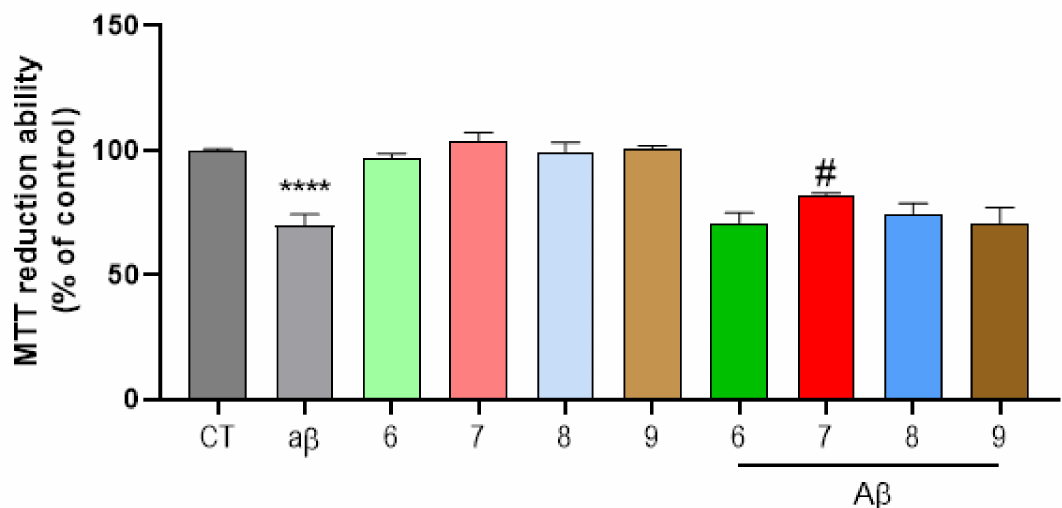
Figure 3. Neuroprotective effect of substances on A β 42 -induced toxicity on SH-SY5Y cells. SH-SY5Y cells were treated with A β 42 peptide (2.5 µ M) for 24 h in the absence or in the presence of the compounds. When compounds were present, a pre- incubation of 1 h preceded the A β 42 treatment. Cellular viability was measured by using the MTT reduction assay. Results are expressed relatively to SH-SY5Y untreated cells, with the mean ± SEM derived from at least 3 different experiments. **** p < 0.0001, significantly different when compared with SH-SY5Y untreated cells (CT); # p < 0.05, significantly different when compared with A β 42 treated SH-SY5Y cells. Compounds: 6 (40 µ M); 7 (15) µ M; 8 (30 µ M); 9 (2.5 µ M).